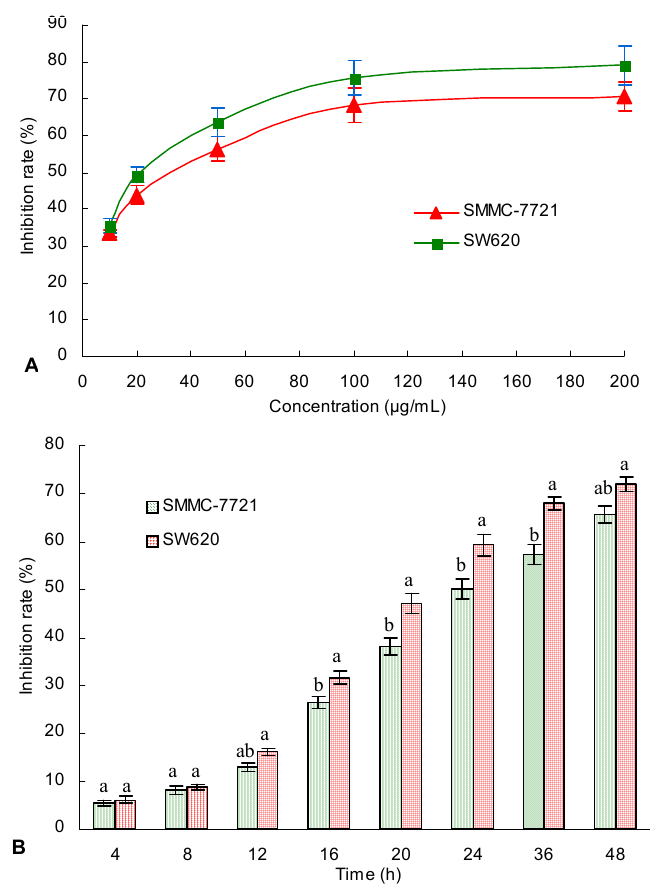
Figure 6. In vitro antitumor activities of triterpene acid extract (TAE) from the mycelium of Ganoderma lingzhi against human hepatoma SMMC-7721 and human colon carcinoma SW620 cells at different concentrations ( A ) or at different treatment times ( B ) with a final concentration of 33.1 μ g/mL TA. The data points are the means ± standard deviations ( n = 3). Different letters indicate significant ( p < 0.05) differences between treatments.